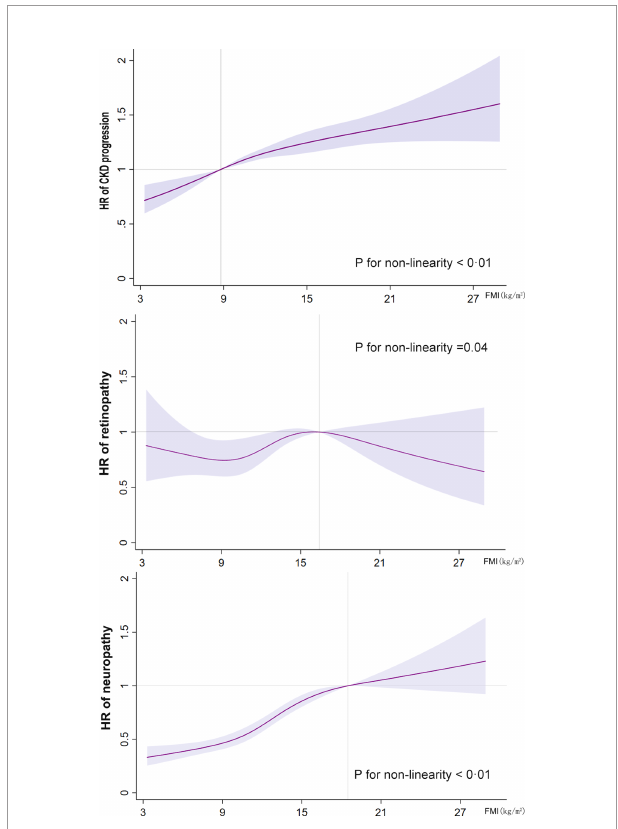
FIGURE 2 | Restricted cubic spline analysis of the fat mass index for the estimation of the risk of the primary endpoints after adjusting for multivariate covariates. Hazard ratios are indicated by solid lines and the 95% con fi dence intervals by shaded areas. The reference point is the in fl ection point for each FMI (8.8 kg/m 2 for CKD progression, 16.4 kg/m 2 for retinopathy, and 18.5 kg/m 2 for neuropathy), with knots placed at the fi fth, 35th, 65th, and 95th percentiles of each FMI distribution. The hazard ratios shown are adjusted for model 3, including age, race, sex, treatment effect, diabetes duration, proteinuria, current smoking, weekly alcohol consumption, height, glomerular fi ltration rate, total cholesterol, low-density lipoprotein cholesterol, high-density lipoprotein cholesterol, systolic blood pressure, and hemoglobin A1C. CKD, chronic kidney disease; FMI, fat mass index; HR, hazard